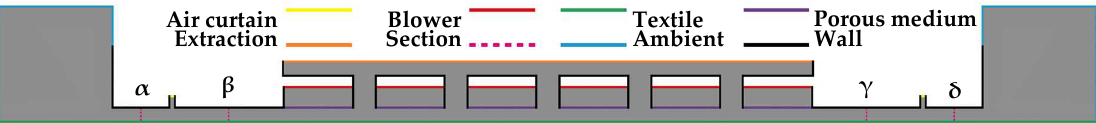
Figure 7. Schematic of the fluid domain with highlighted boundaries and control sections.